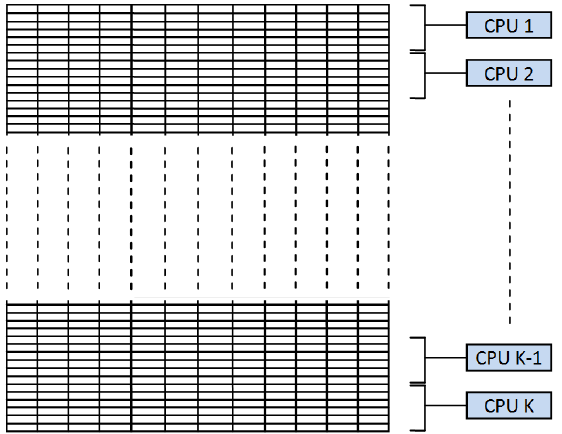
Figure 1: Rows assignment to the available processors. Each processor performs the t-norm/t-conorm calculation for a subset of rows of the resulting